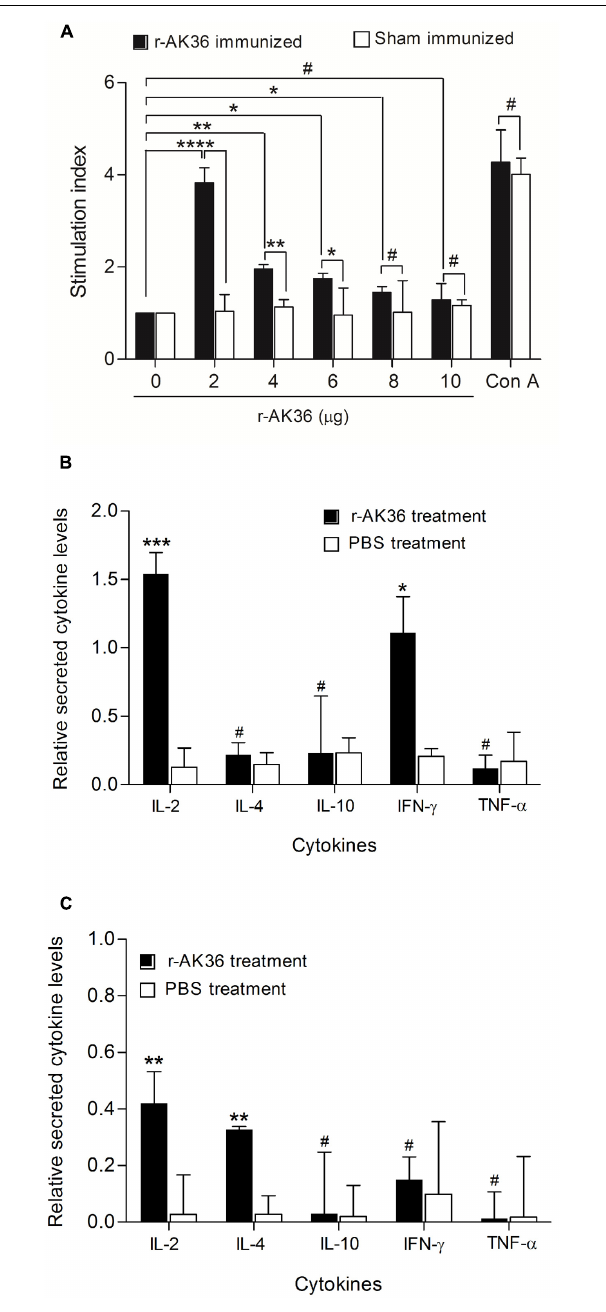
FIGURE 4 | Lymphocyte proliferation and cytokine analysis from splenocytes of r-AK36-immunized and sham-immunized mice. (A) Proliferation of lymphocytes isolated from r-AK36-immunized and sham-immunized BALB/c mice and treated with r-AK36 protein at different concentrations for 72 h. (B) Bar graphs showing mean cytokine levels relative to positive controls in conditioned media of splenocytes isolated from r-AK36 immunized BALB/c mice, after stimulation for 3 days with r-AK36 protein. (C) Bar graphs showing mean cytokine levels relative to positive controls in conditioned media of splenocytes isolated from sham-immunized BALB/c mice, after stimulation for 3 days with r-AK36 protein. All results are the average of three independent experiments. Significance ( P )-value summary analyzed by univariate ANOVA: ∗ P ≤ 0.05, ∗∗ P ≤ 0.01, ∗∗∗ P ≤ 0.001, ∗∗∗∗ P ≤ 0.0001; no significance #.